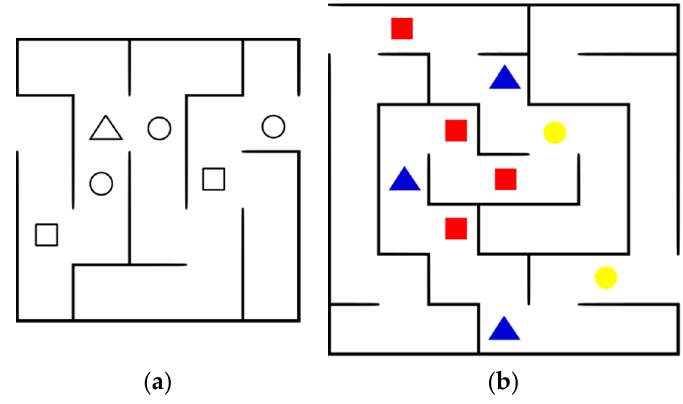
Figure 4. Difficulty levels: ( a ) Basic; ( b ) Advanced.